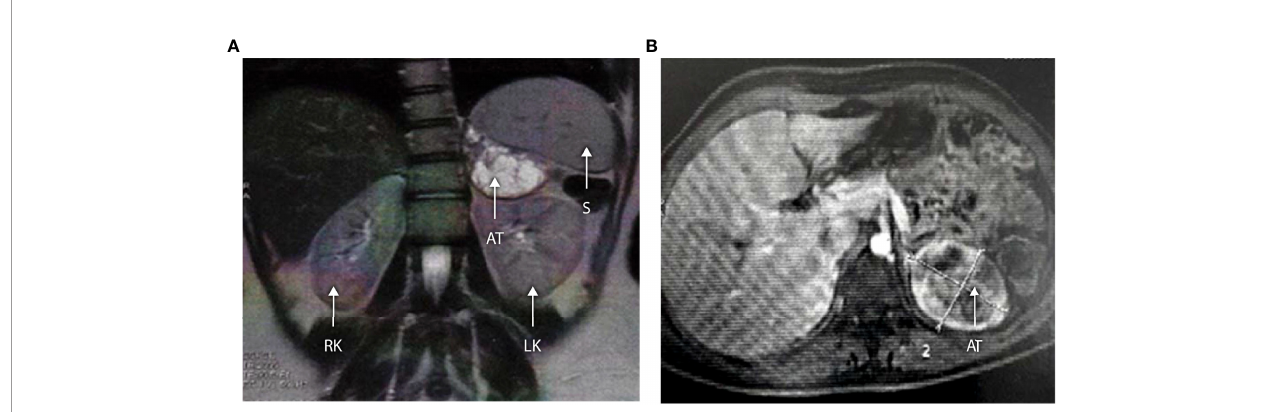
FIGURE 4 | (A, B) Abdominal MRI scan in a 16-year-old with 3 b HSD2 de fi ciency (Patient B II-1). Axial and coronal sections demonstrate a large left-sided adrenal tumor measuring 63 × 52 × 51 mm. The lesion shows central cystic degeneration and is pushing the kidney downwards. RK, right kidney; LK, left kidney; S, spleen; AT,